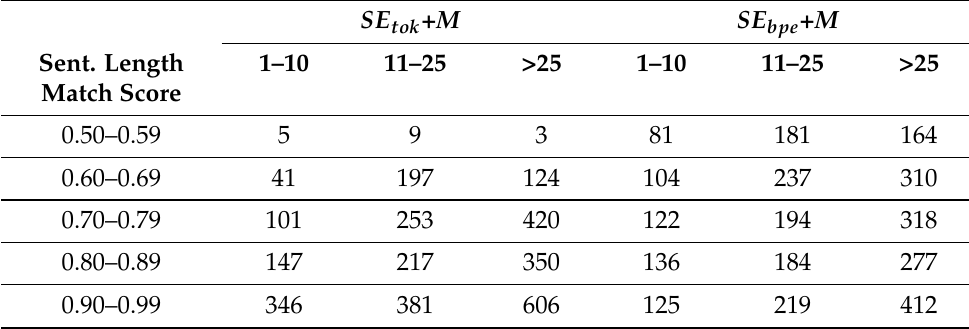
Table A5. Bin sizes per match range and sentence length (in number of words) for EN-HU. SE tok +M SE bpe +M Sent.